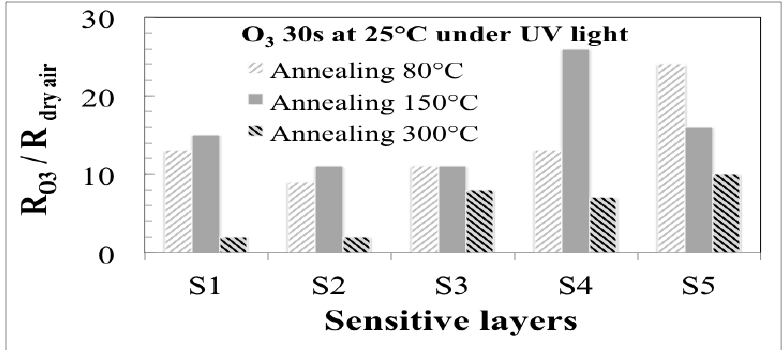
Figure 4. Sensor responses for 165 ppm of O 3 at 25 °C under UV light for three post-annealing